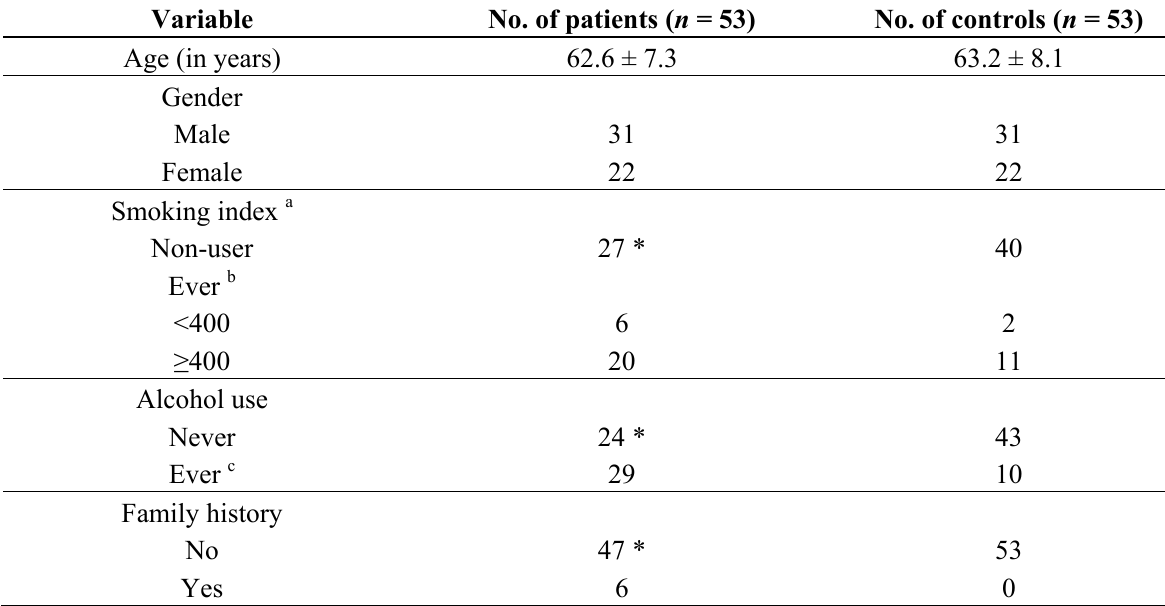
Table 1. Characteristics of ESCC patients and